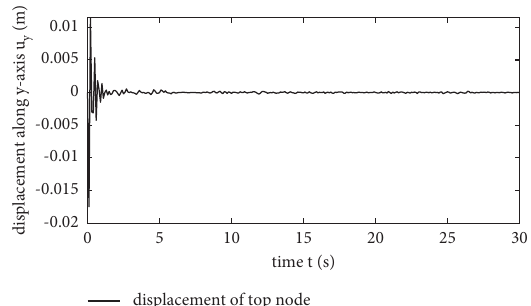
Figure 7: Displacement of top node (o) along the (y)-axis.